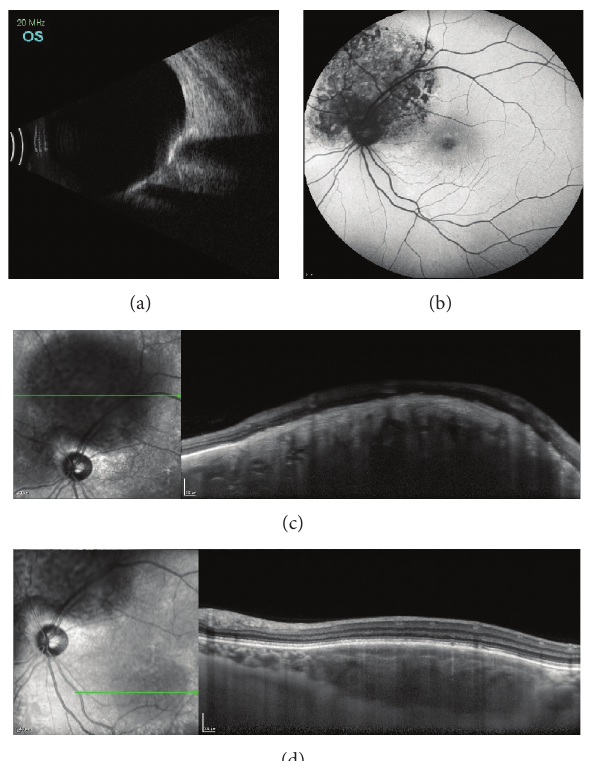
Figure 2: (a) Ultrasound showing a hyperreflective line with acoustic shadowing. (b) Autofluorescence of the left eye. The juxtapapillary tumor presents a hyperautofluorescence and hypoautofluorescence granular pattern. The paramacular tumor presents an isoautofluorescence pattern. (c) EDI-OCT of the juxtapapillary choroidal osteoma showing alterations on the external retina and the sponge-like structure. (d) EDI-OCT of the paramacular tumor shows an intact